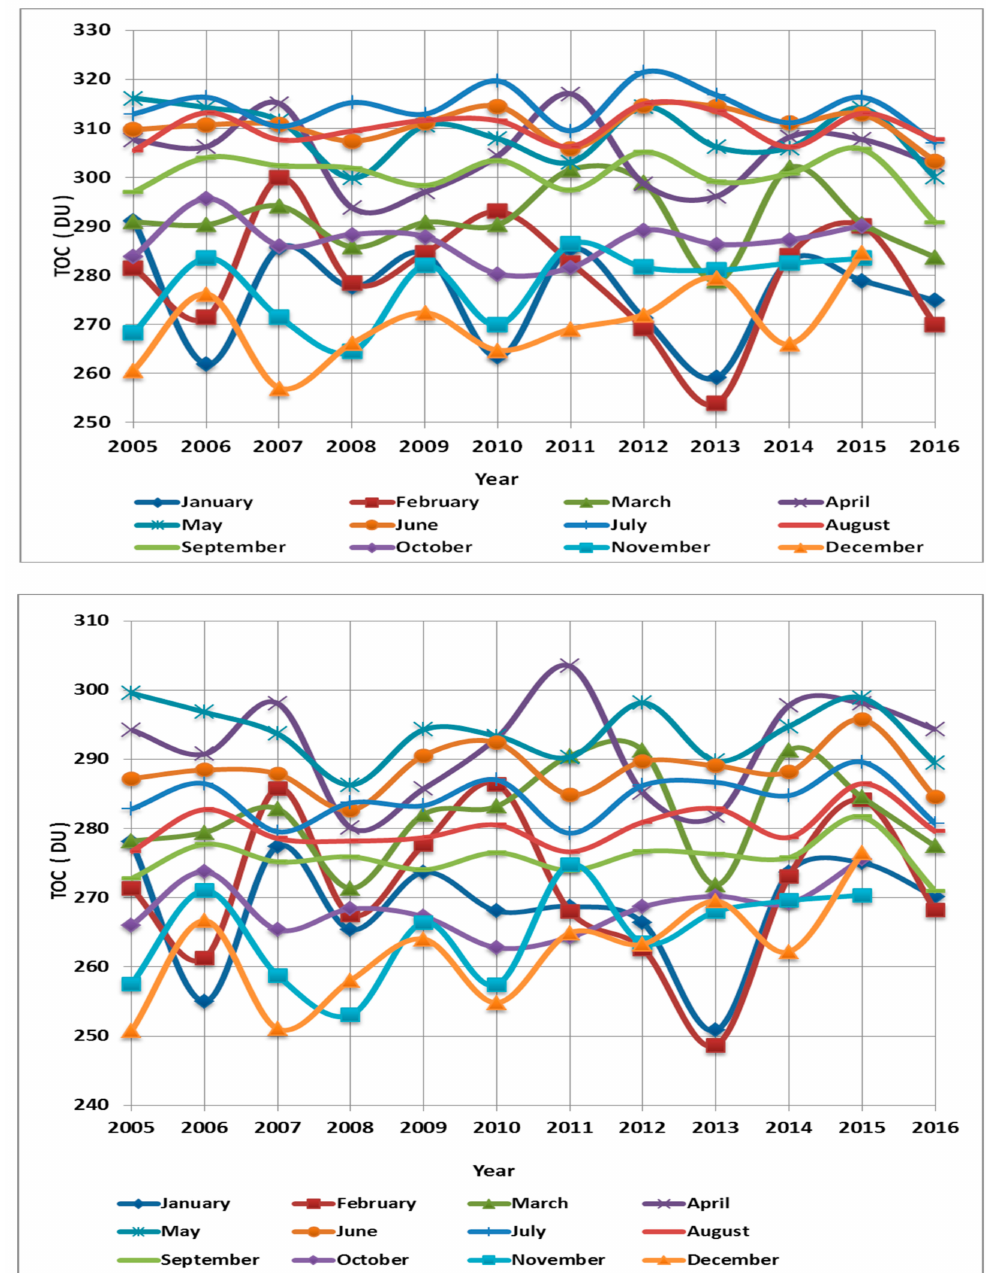
Figure 3. Interannual monthly average time series of TOC in Dobson Units (DU) over Egypt for the period (2005–2016) from AIRS ( upper ) and MERRA-2 ( lower